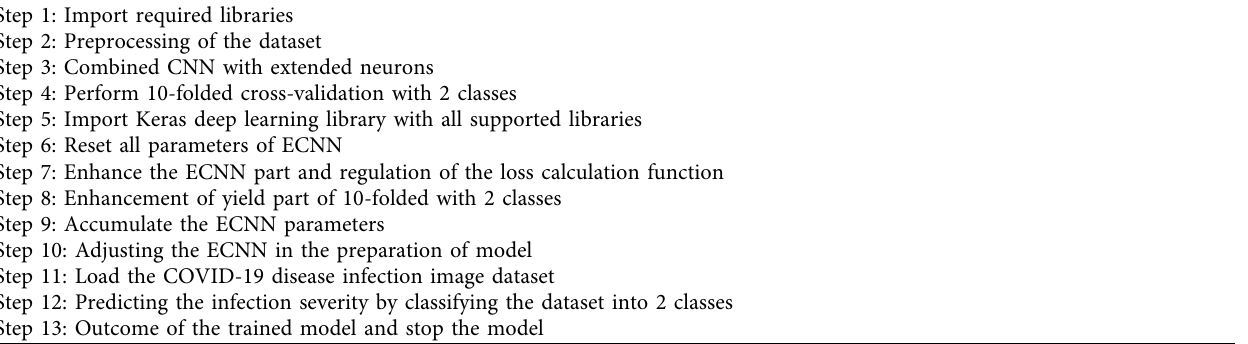
Figure 3: COVID-19 ECNN graph comparing accuracy vs. epoch. Table 2: ECNN proposed model steps.